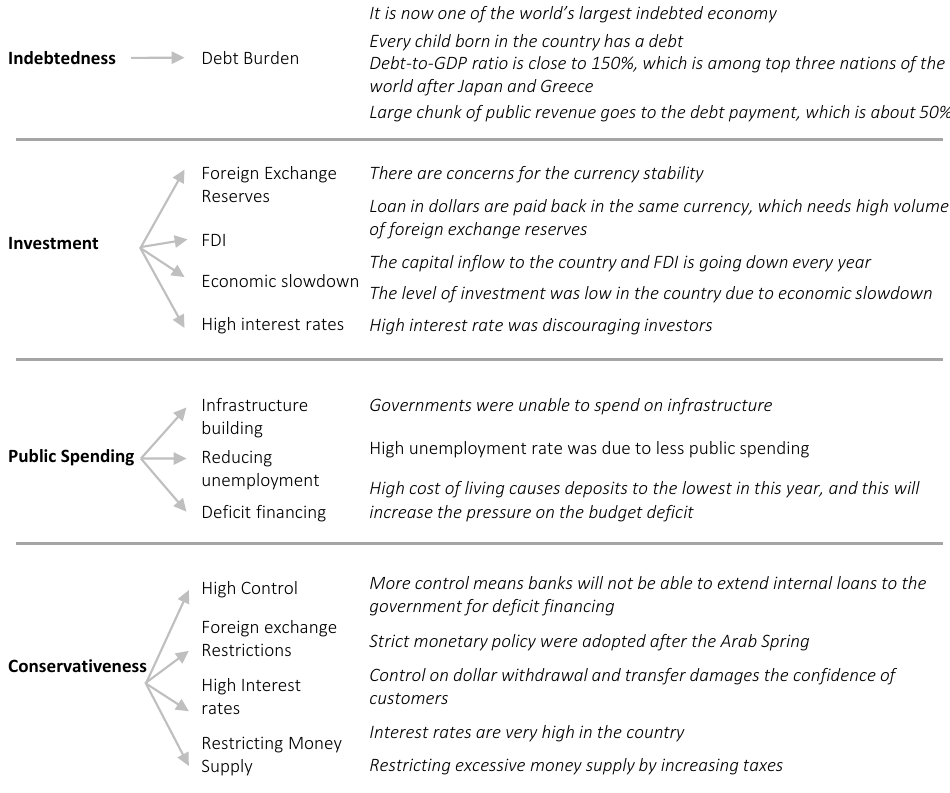
Figure 6. Thematic construct of Fiscal and Monetary Policies